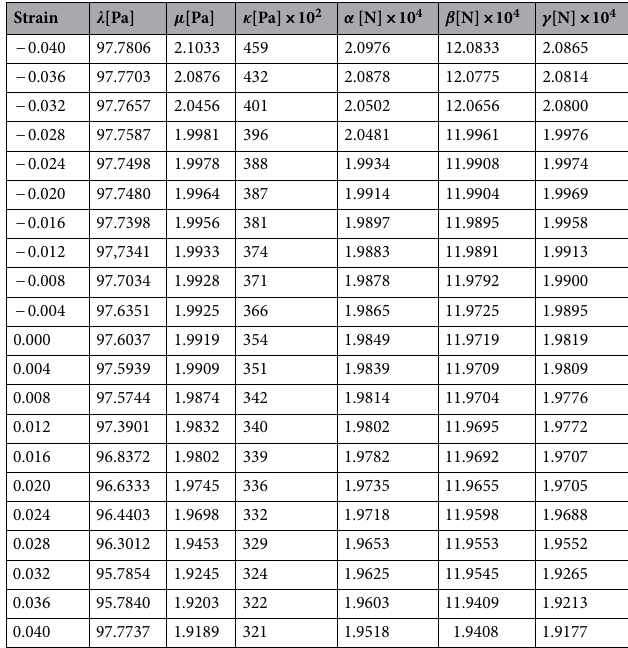
Table 1. Estimates for elastic constants in the ( X , Y , Z ) coordinates as a function of